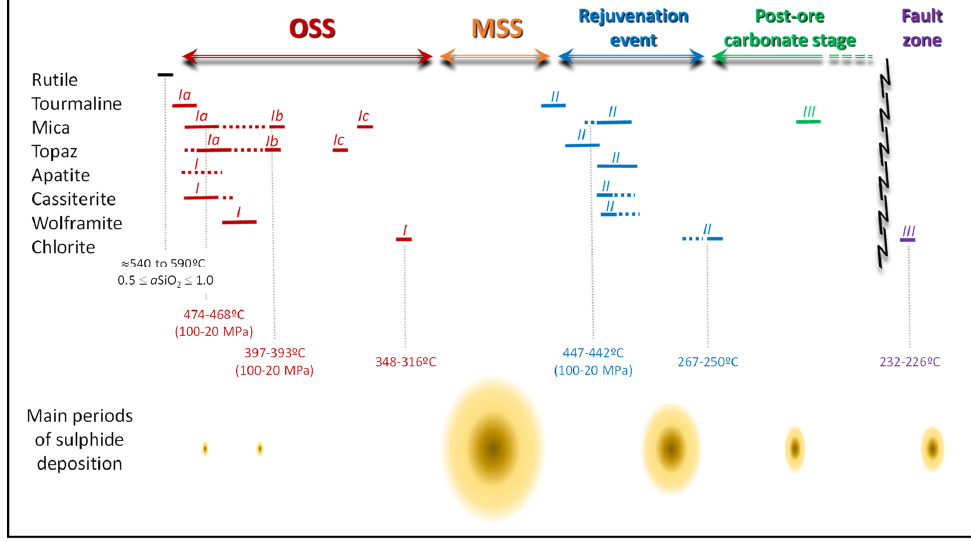
Figure 16. Synoptic outline of temperature conditions and relative position of the main silicates (tourmaline, white mica, topaz and chlorite), oxides (rutile, cassiterite and wolframite) and phosphates (mostly apatite) examined in this work. Sulfide deposition is indicated for general reference and the size of each